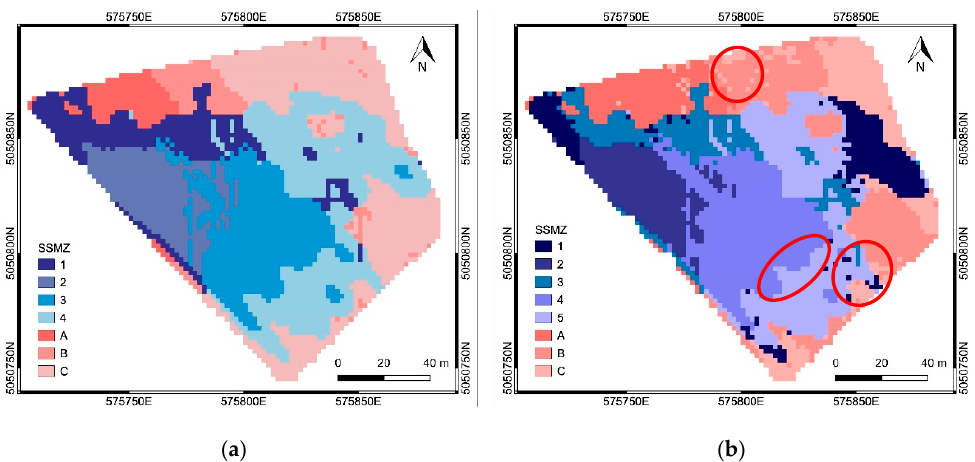
Figure 12. The SSMZ map obtained from: ( a ) EC, elevation and slope maps; ( b ) EC, elevation, slope and NDVI. Sensors 2019 , 19 , x FOR PEER REVIEW